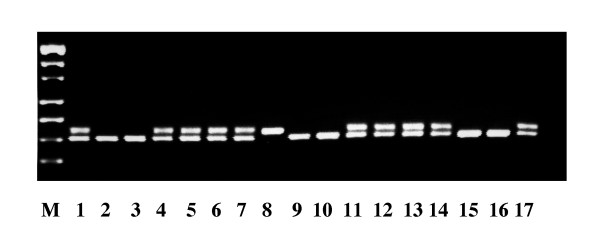
Genotyping the FANCA promoter polymorphism by PCR. Allele 1 amplifies as a band of 151 base pair, allele 2 as a band of 164 base pair. The 3 genotypes are readily distinguishable on a 3 % agarose gel run at 100 V for 1 hour. Homozygous samples for both allele 1 and allele 2 are shown as are heterozygous samples which have both bands.